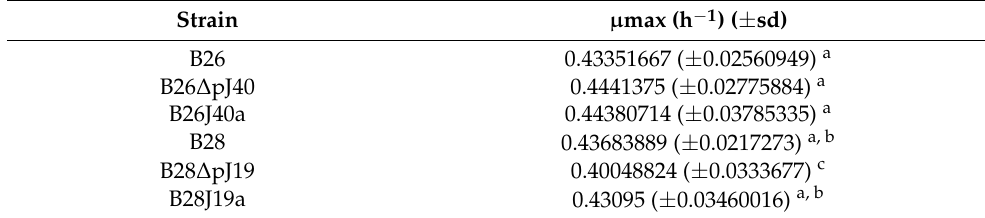
Table 3. Growth rates of strains with and without the pTsB26